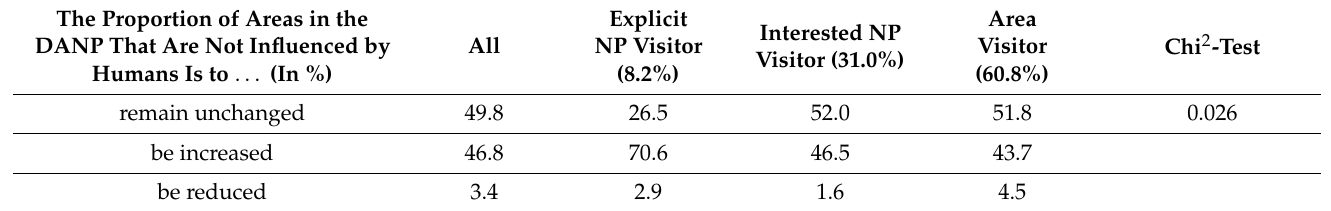
Table 5. Attitudes of visitor segments toward changes in natural areas of the DANP (n =